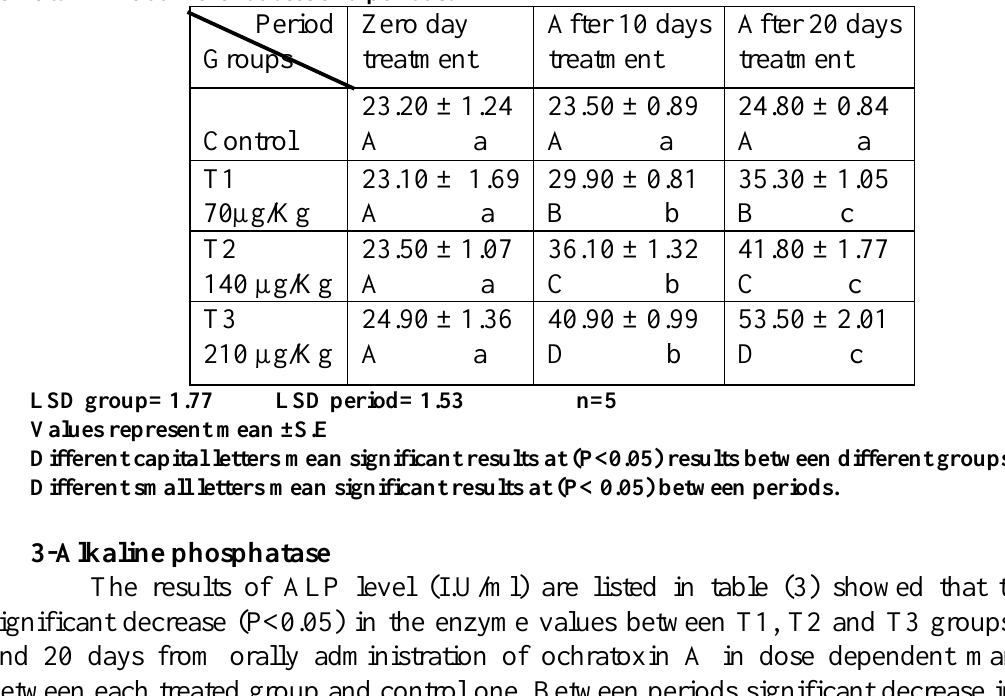
Table (2): ALT level (I.U/ml) in rats serum of different experimental groups dosed orally with ochratoxin A at different doses and periods.